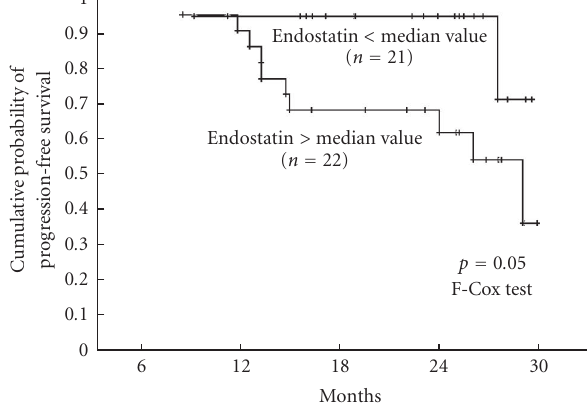
Figure 3: Cumulative probability of progression-free survival in 52 untreated CLL patients stratified on the basis of median value of endostatin (ie, 8.12